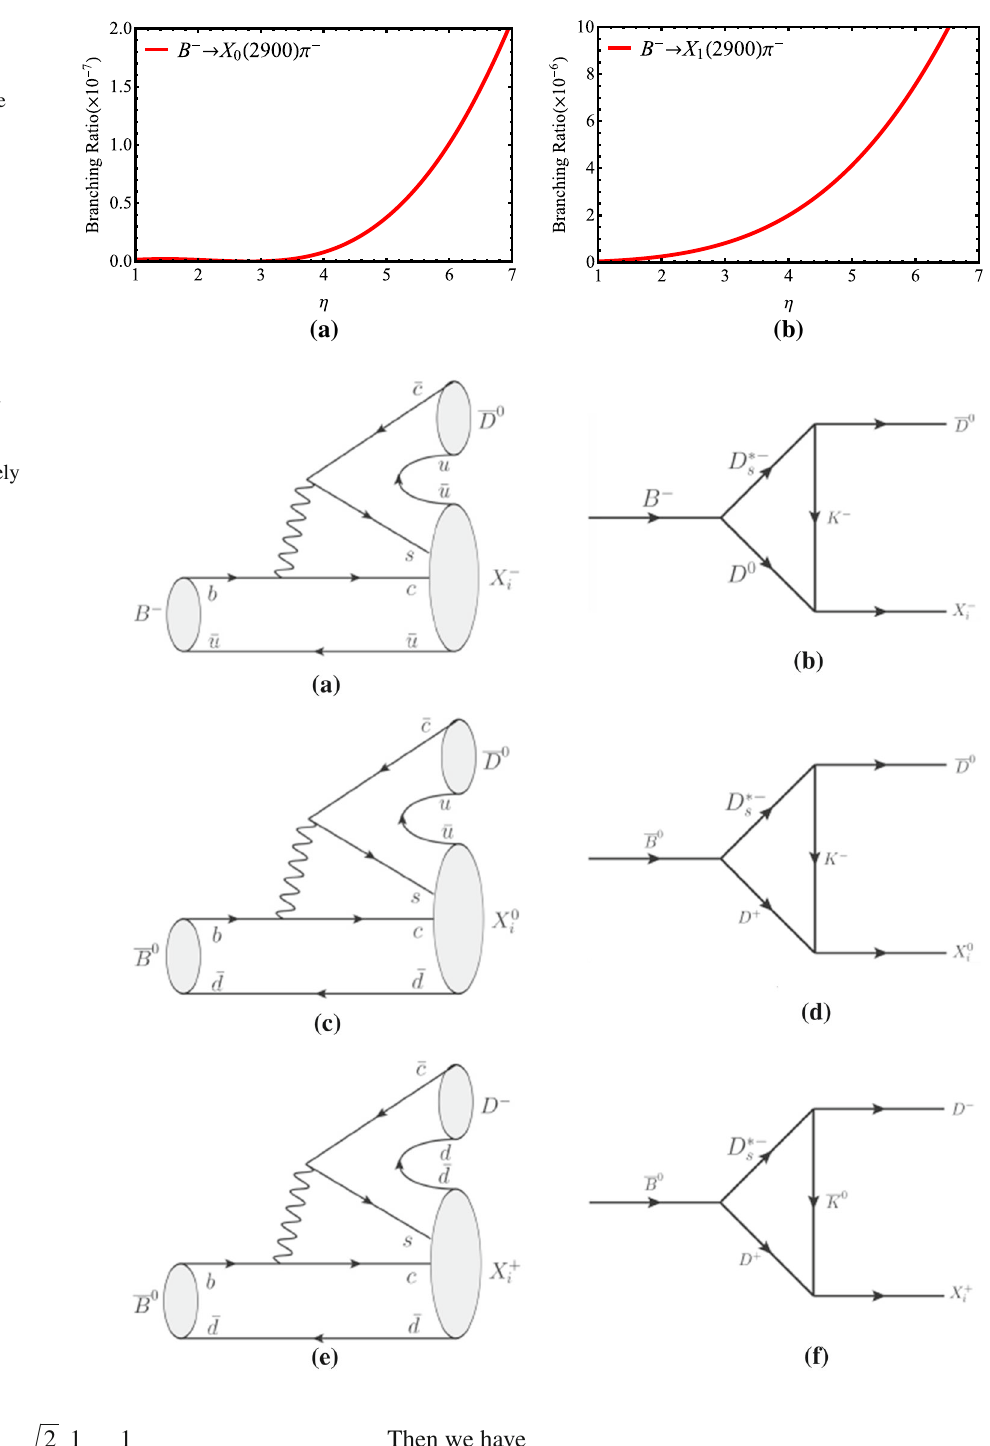
hadronic triangle diagrams of and B 0 → D − X +